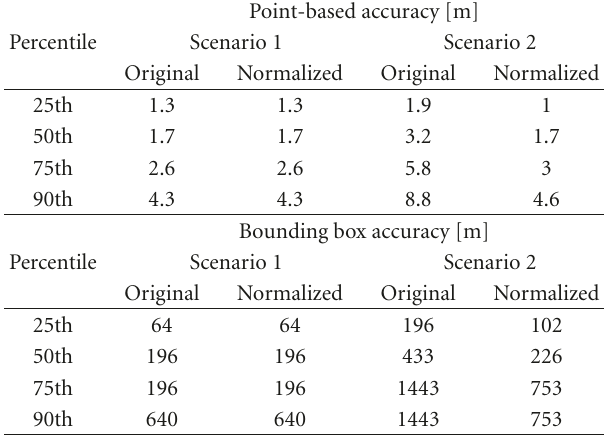
Table 3: Comparison of point-based and bounding box accuracies for Scenario 1 and Scenario